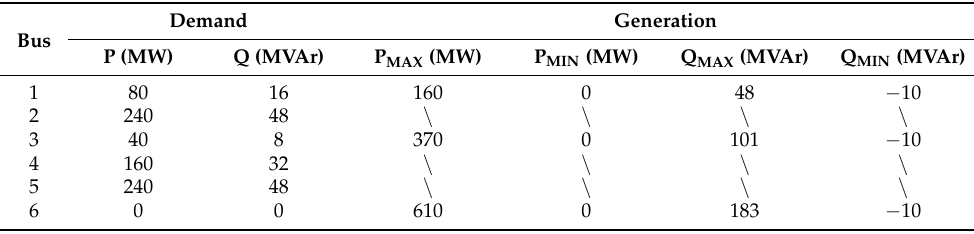
Table 2. Garver’s six-bus system